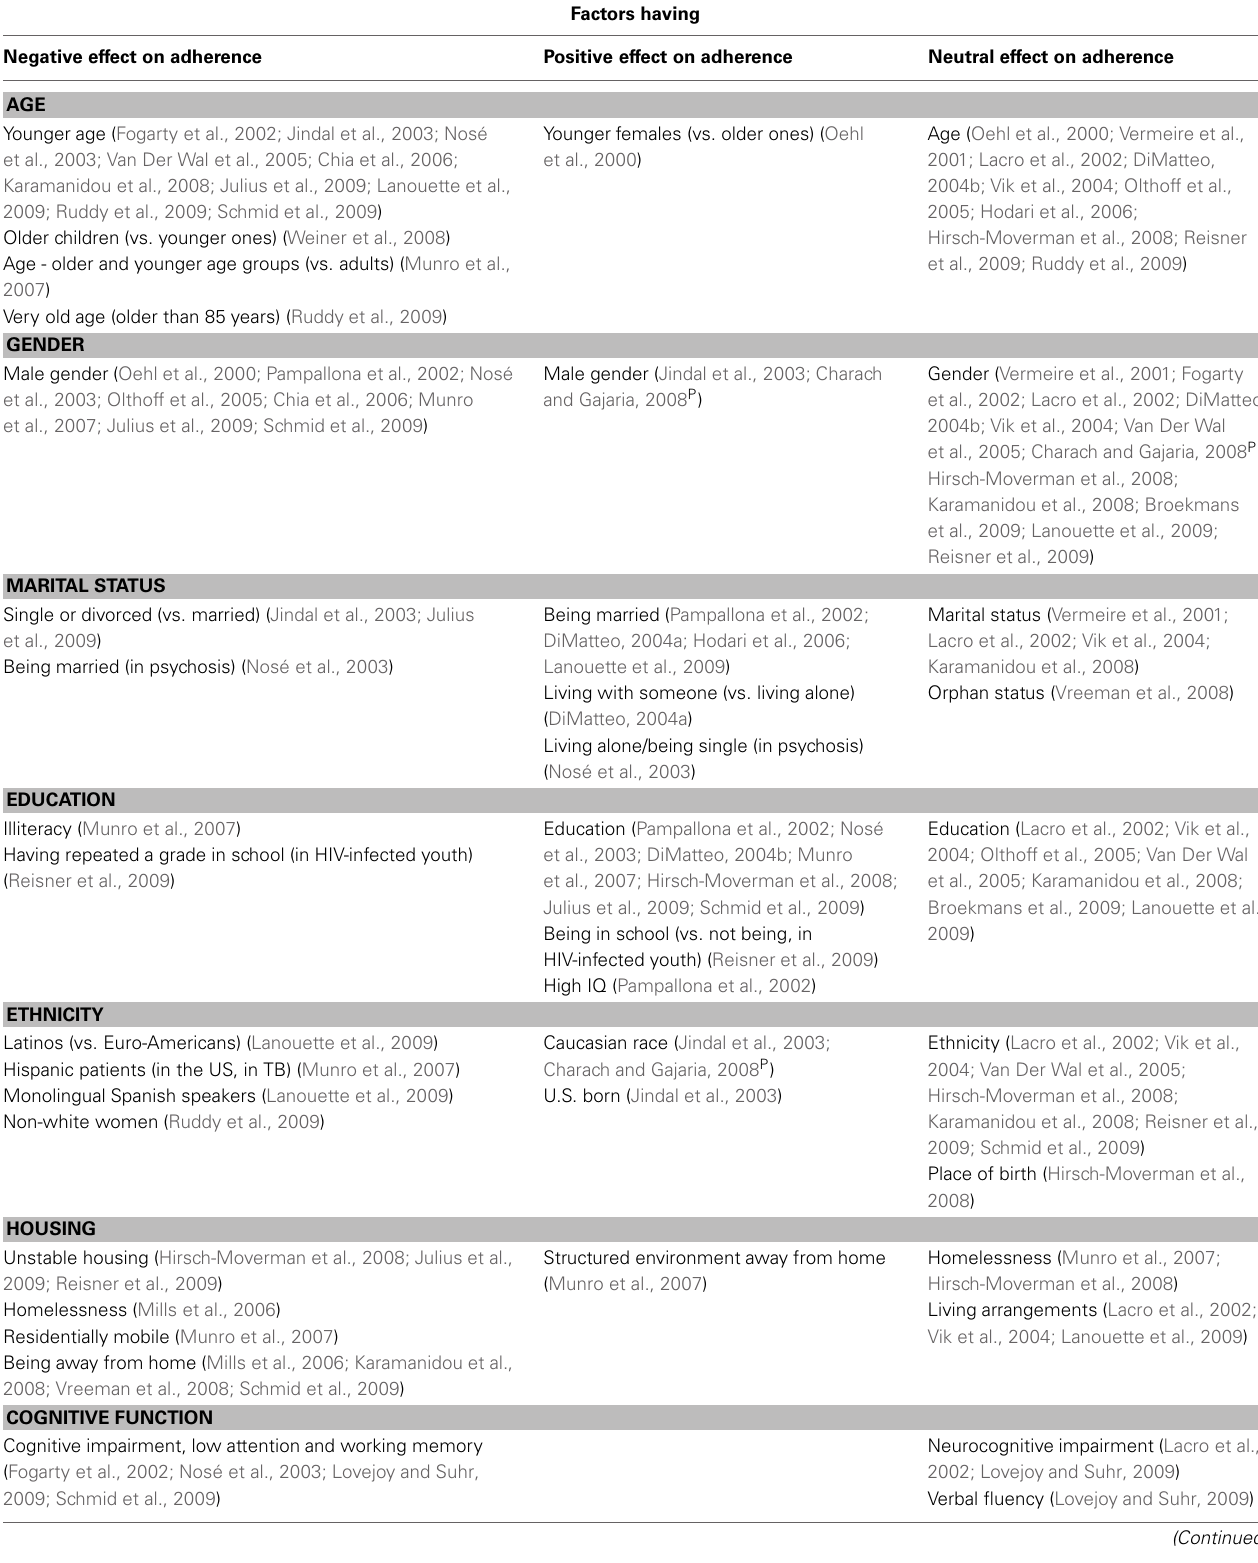
Table 7 | Patient-related factors affecting